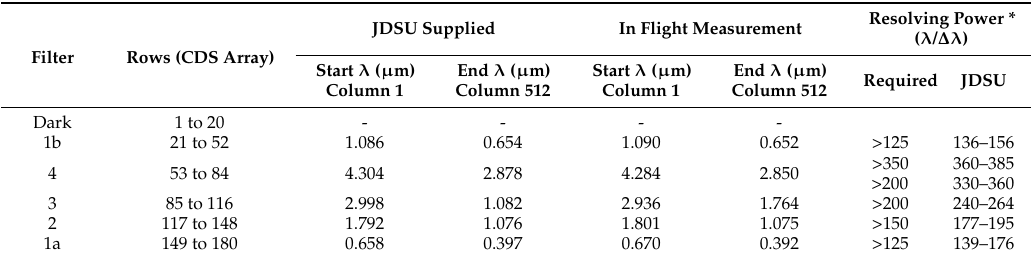
Table 2. Wavelengths in each filter